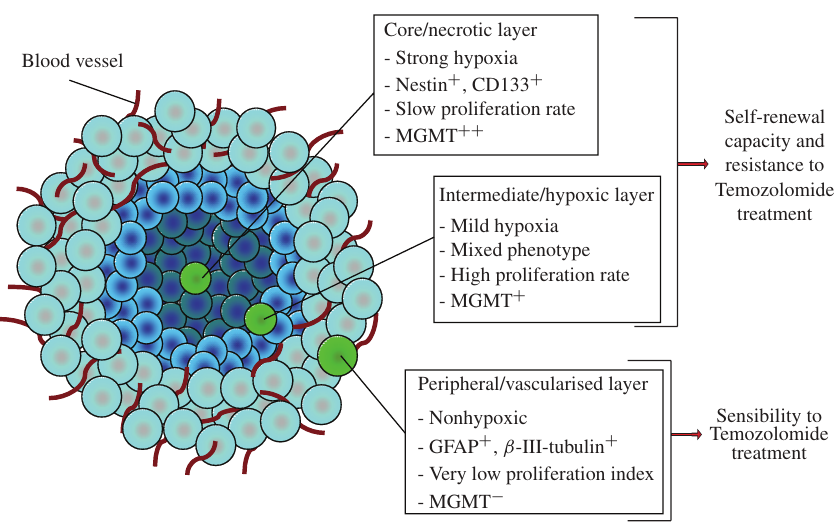
FIGURE 2: Phenotypic and molecular characteristics of the three concentric layers model of GBM. Inner portions of tumor mass display more immature cancer cells (Nestin + ) and account for the highest percentages of cancer stem cells identified by CD133 staining. This identified stem cell population is resistant to alkylating agents-based chemotherapy in vitro . Peripheral GBM cells show a more differentiated phenotype (GFAP+, β -III-tubulin + ) with low levels or absence of CD133 + cells. These peripheral tumor cells are highly sensitive to